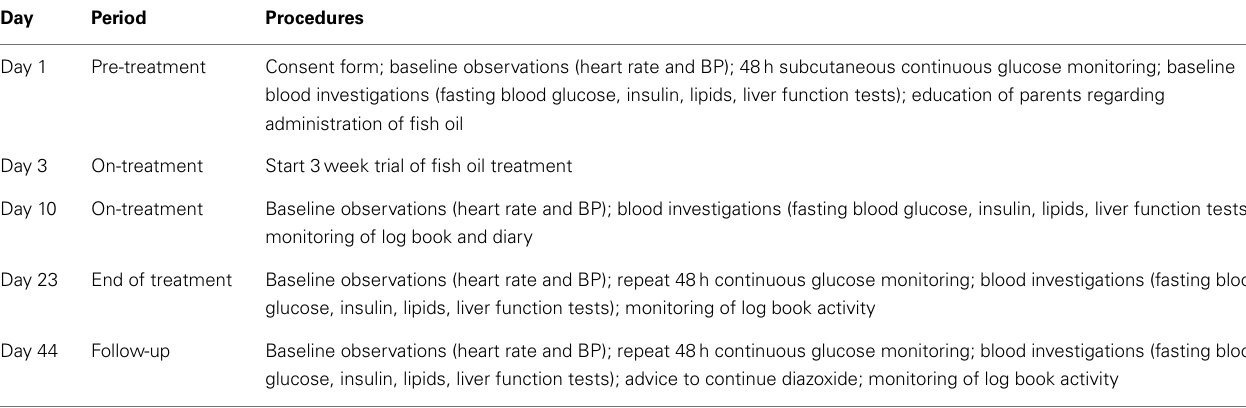
Table 1 | Investigation, monitoring, and treatment protocol for patients with CHI recruited to the trial, showing time, time periods, and procedures in columns (BP, blood